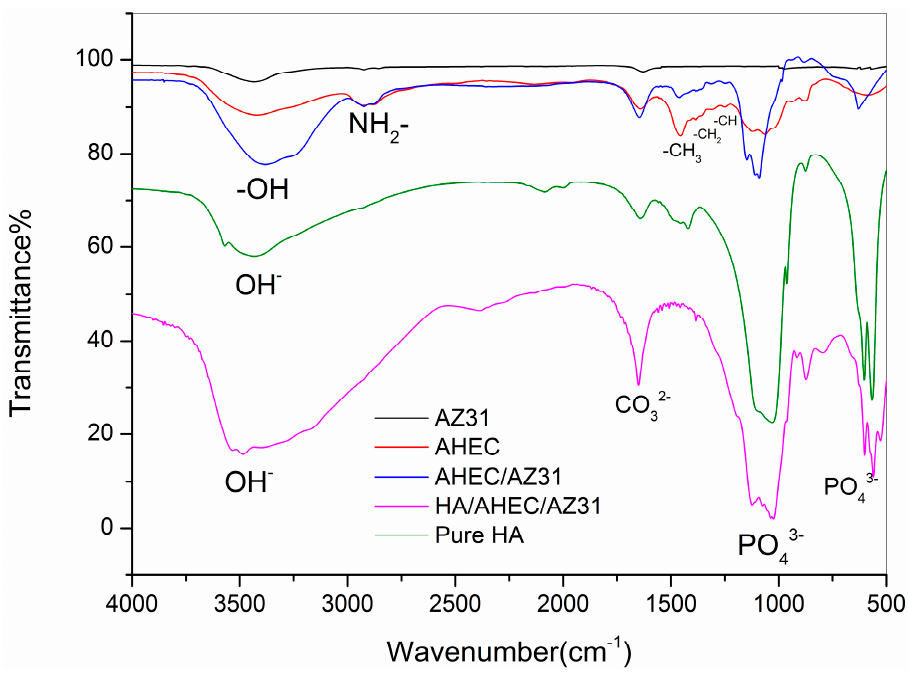
Figure 3. Fourier-transform infrared (FT-IR) spectrum of AZ31, AHEC, AHEC/AZ31, HA/AHEC/AZ31, and Pure HA.